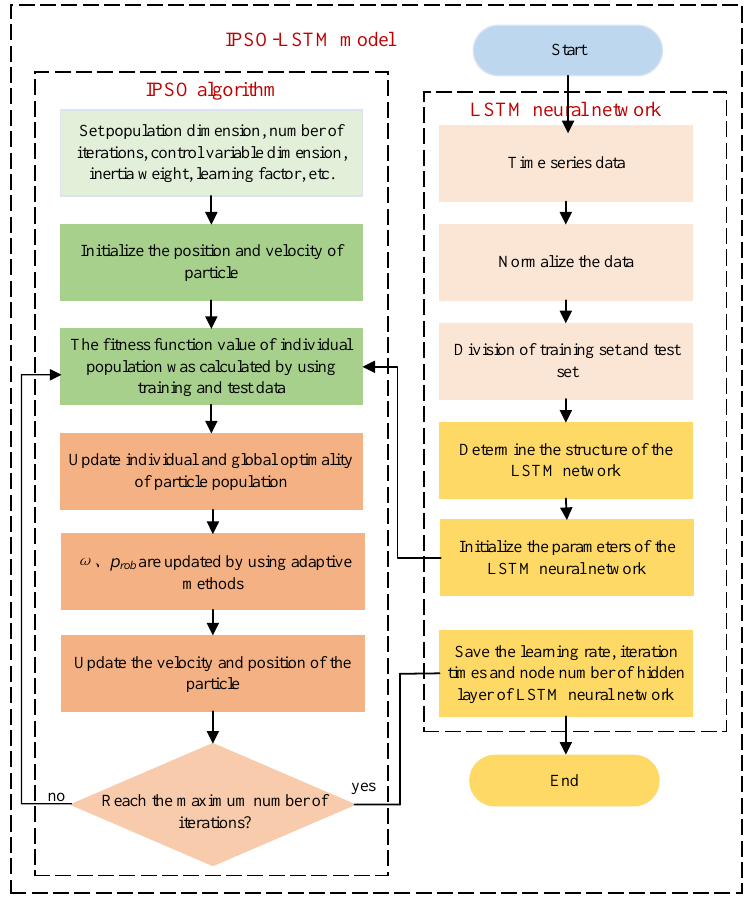
Figure 6. The flow of the IPSO – LSTM algorithm.